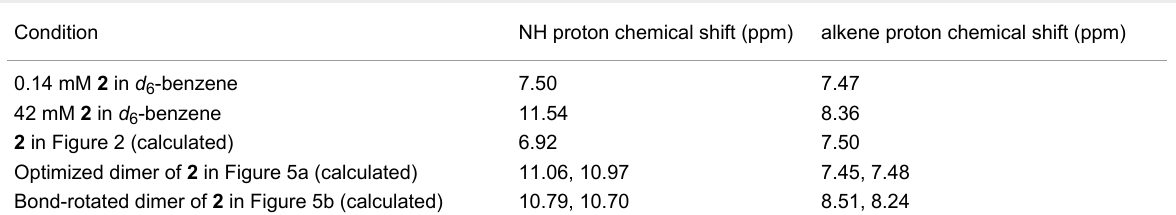
Table 2: Experimental versus calculated proton chemical shifts in the dimers shown in Figure 5. a